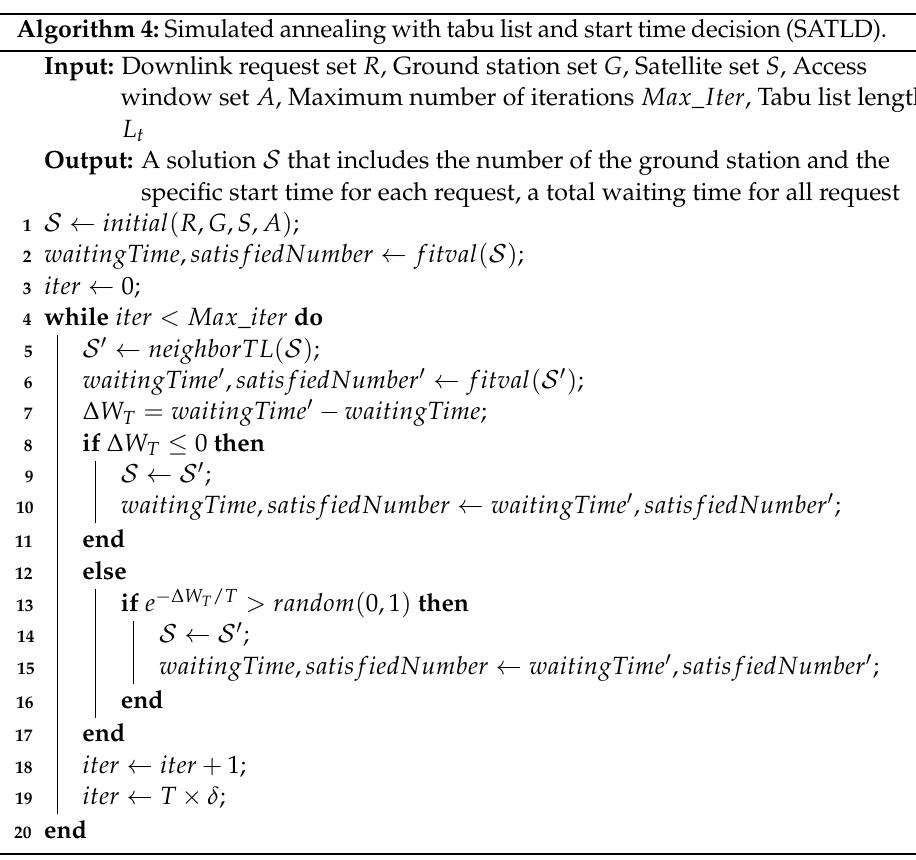
Algorithm 4: Simulated annealing with tabu list and start time decision